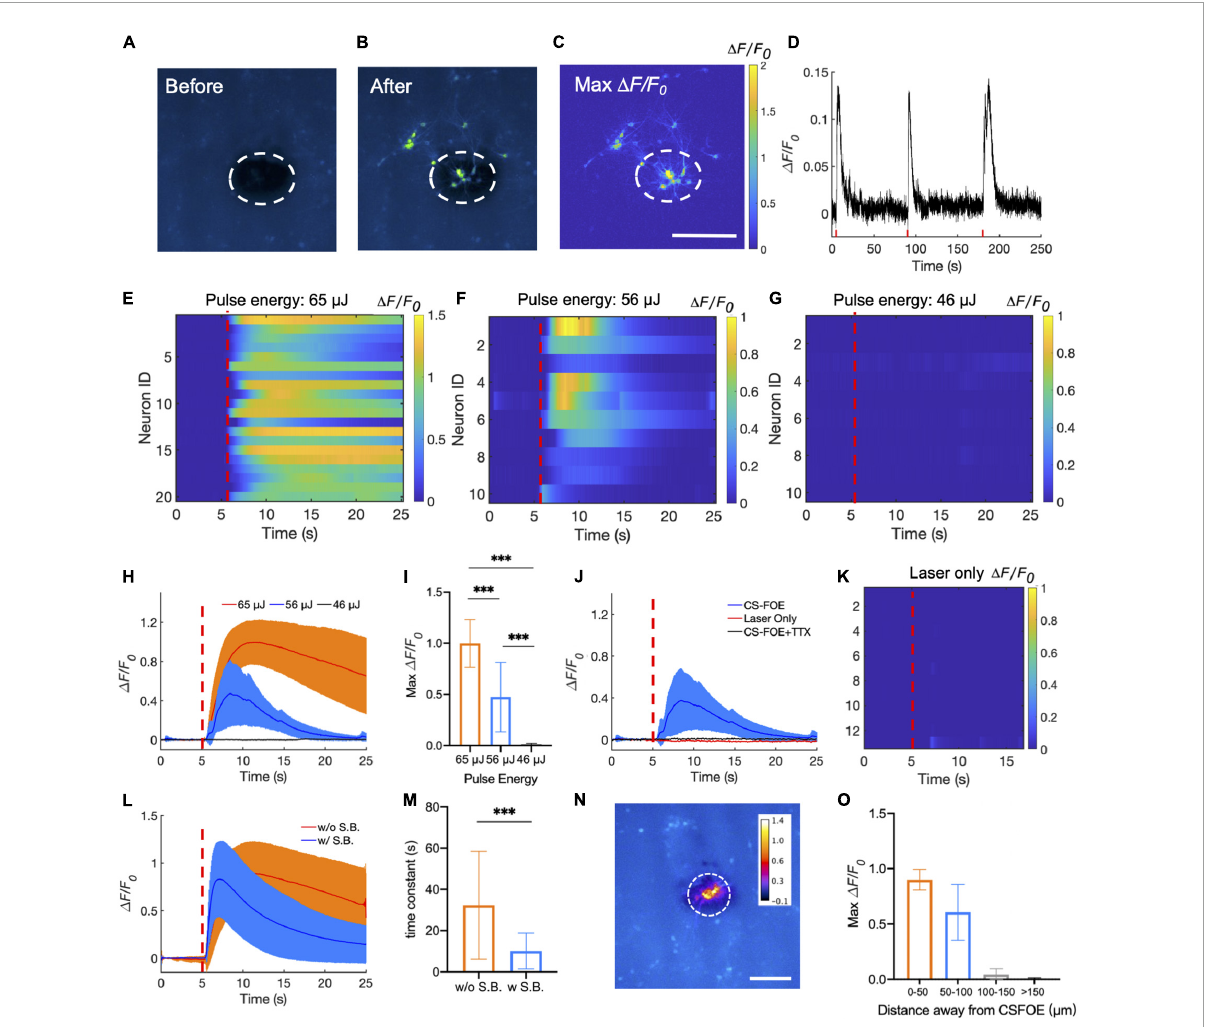
FIGURE3 Activation of GCaMP6f -expressing cortical neurons by CSFOE stimulation. (A,B) Representative fluorescence of neurons from three batches stimulated by CSFOE before stimulation (A) and after stimulation (B) . (C) Map of the maximum fluorescence change (cid:49) F / F 0 induced by the CSFOE stimulation. Laser condition: 3 ms duration, pulse energy 65 µ J. Scale bar: 200 µ m. (D) Calcium trace shows repeatable activation of the same neuron. Laser condition: 3 ms duration, pulse energy 56 µ J. (E–G) Colormaps of fluorescence change in neurons stimulated by CSFOE with a laser pulse energy of 65 µ J (E) ( N = 20), 56 µ J (F) ( N = 10), and 46 µ J (G) ( N = 10). (H) Average calcium traces of neurons obtained from (E,F,G) with the pulse energy of 65 µ J (Red) ( N = 20), 56 µ J ( Blue ) ( N = 10 ) and 46 µ J (black) ( N = 10), respectively. The shaded region corresponds to one standard deviation. Laser turns on at t = 5 s (red dashed lines). The duration of each stimulation was fixed at 3 ms. (I) Average of maximum fluorescence intensity changes shown in (E–G) . Error bars represent standard deviation. *** p < 0.001, one way AVOVA test. (J) Average calcium traces of neurons of CSFOE stimulation, Laser only control and TTX control. Each group was repeated three times on three different dishes of neurons ( N = 10 for each condition). (K) Colormaps of fluorescence change in neurons of a laser only control group. (L) Average calcium traces with (Red) ( N = 30) and without (Blue) synaptic blocker ( N = 30). Laser is on at t = 5 s. laser condition: 1,030 nm, 1.7 kHz repetition rate, 65 µ J pulse energy (M) Time constant of the decay of the fluorescence trace with and without synaptic blockers. *** p < 0.001, two sample t -test. (N) Spatial distribution of maximum neuronal calcium response induced by CSFOE stimulation. Scale bar: 200 µ m. Dashed circle: indication of the CSFOE position. (O) Maximum (cid:49) F / F µ m 0 changes over the distance away from the CSFOE ( N = 6 for 0–50 group, N = 4 for 50–100 µ m group, N = 5 for 100–150 µ m group, N = 7 for > 150 µ m